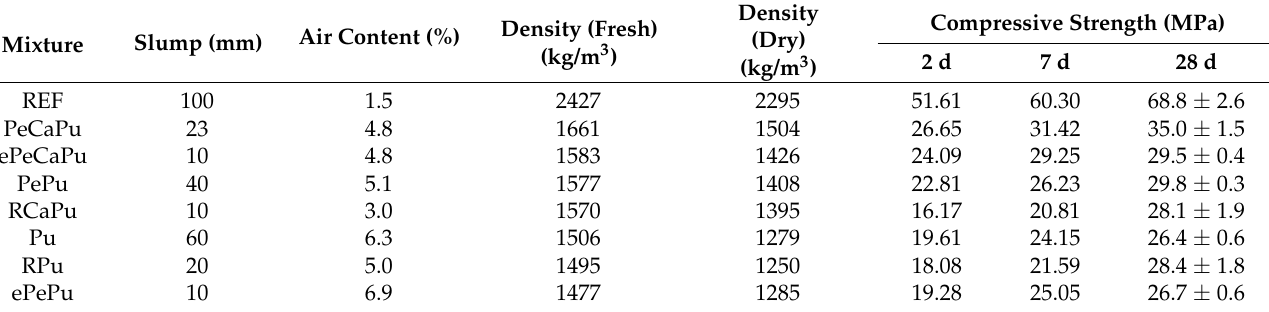
Table 4. Test results for all concrete mixtures in fresh and hardened